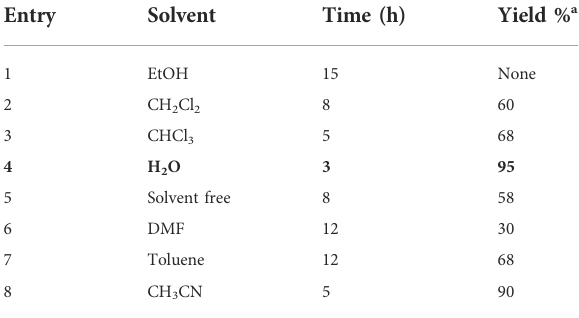
a Isolated yields. Bold indicates best condition for performing reactions.